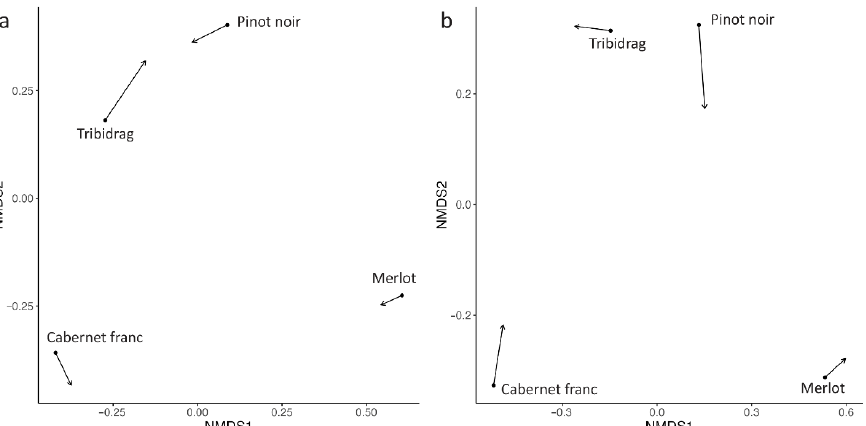
Figure 2. Procrustes analysis based on the NMDS plots of yearly changes (from 2020 to 2021) in grapevine parameters selected by DAPC analysis for ( a ) leafroll and ( b ) wild-type virus treatments. There was a significant correlation between the yearly changes for the leafroll treatment (R2 = 0.27, p < 0.01) and wild-type treatment (R2 = 0.34, p < 0.01).